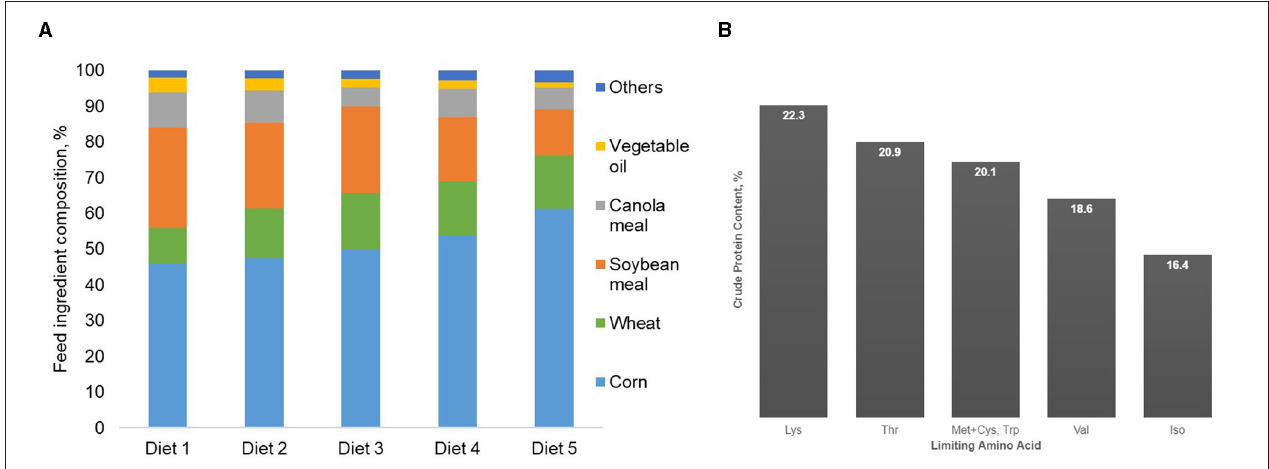
FIGURE 1 | Feed ingredient composition of diets formulated for grower pigs (25–50kg BW) in standard Canadian pig diets when soybean and canola meals are gradually replaced by corn and feed-grade amino acids (A) . Crude protein content and limiting AA of diets formulated for grower pigs (25–50kg BW) in standard Canadian conditions when soybean and canola meals are gradually replaced by corn and feed-grade amino acids (B)